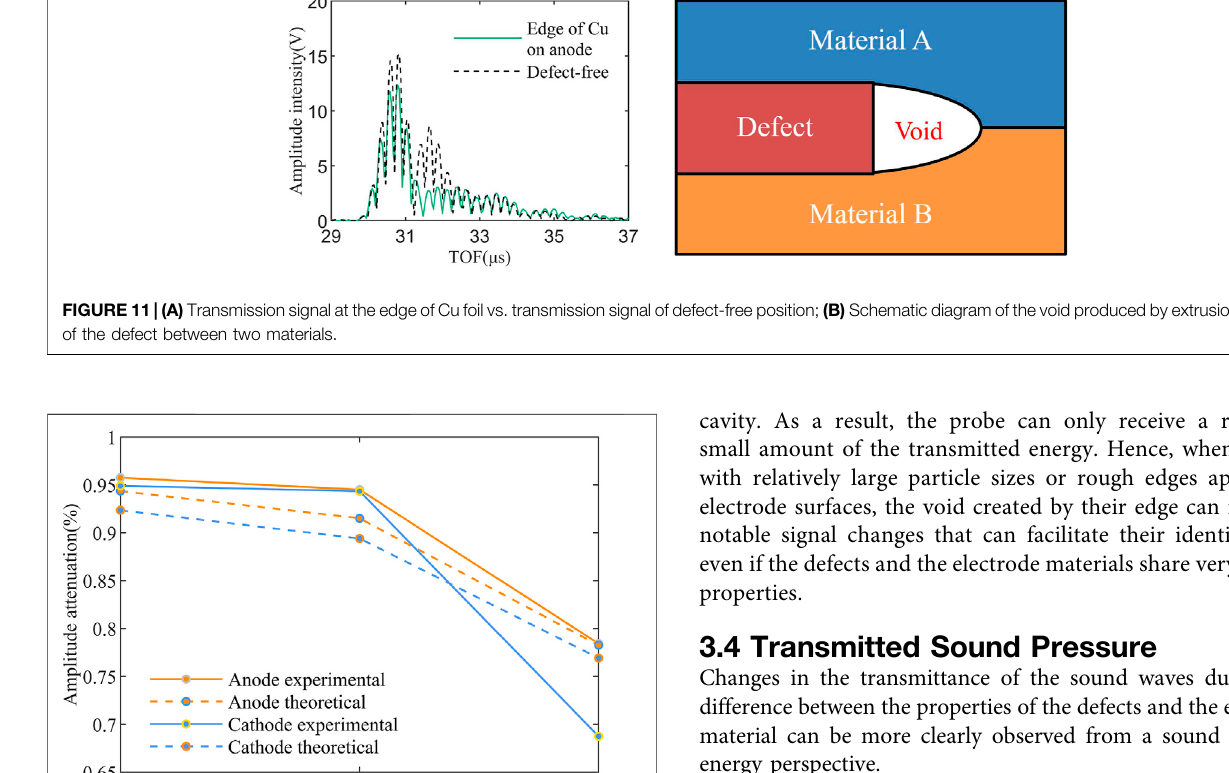
Frontiers in Energy Research |